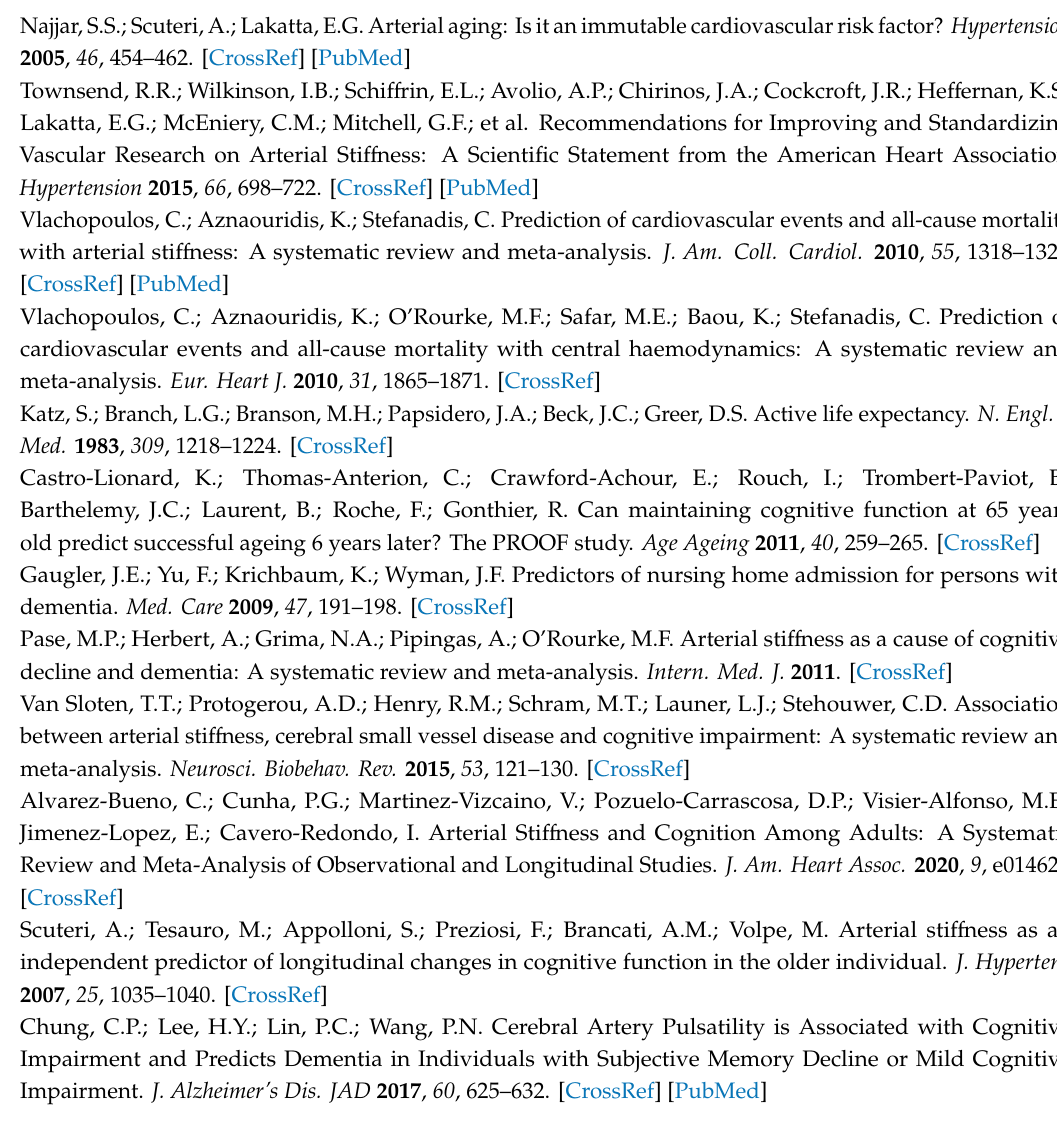
Whey and Carbohydrate groups (mean ± SD), Table S3: Information processing e ffi ciency and executive function at baseline and 12 weeks in